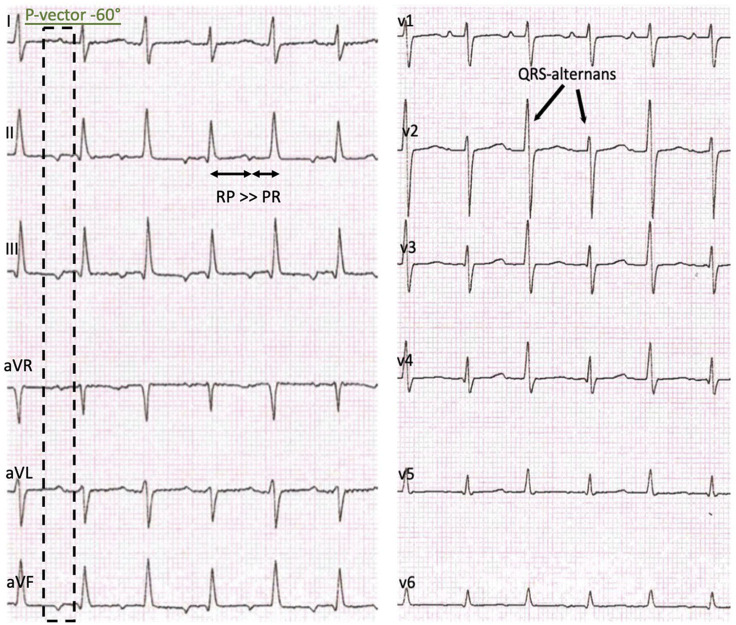
Initial presentation: 12-lead-ECG with a regular sustained small QRS-Complex tachycardia, P-vector −60°, a delay of the atrioventricular conduction, RP > PR and a QRS-complex amplitude alternans.